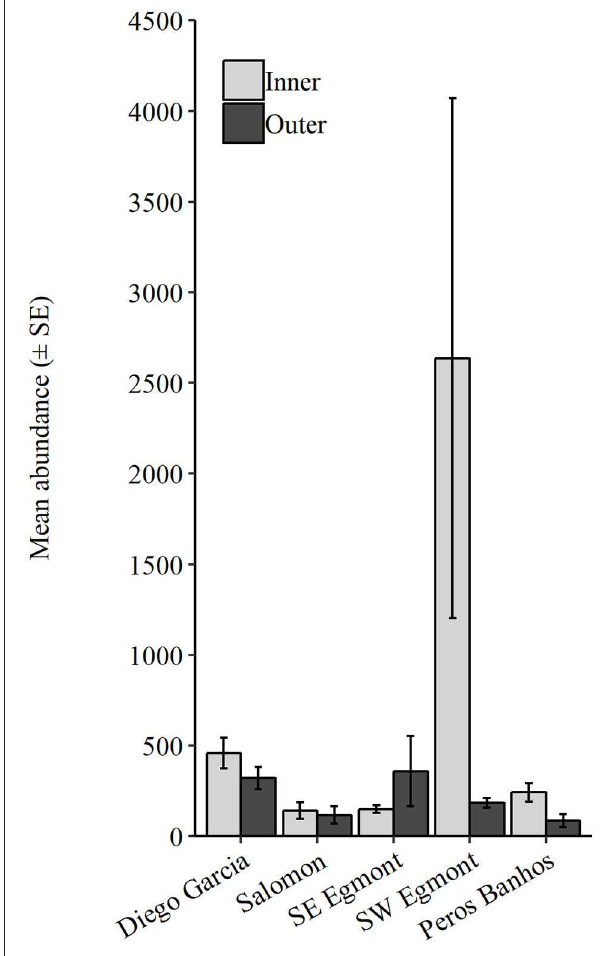
FIGURE 6 | Mean abundance ( ± SE) at Inner and Outer stations, within each of the four atolls. = 150 ± 20.42, Out = 359.33 ± 194.01), Peros Banhos (In = 242.67 ± 49.65, Out = 87 ± 36.67), and Salomon (In = 141.25 ± 45.94, Out = 117 ±